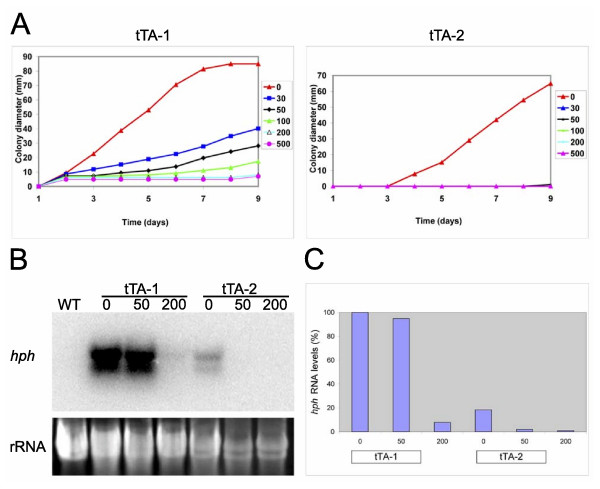
Effects of doxycycline on the hygromycin sensitivity of two A. fumigatus strains that express tTA (p444) in conjunction with the tetO7-hph reporter gene (p482). (A): Ten thousand conidia from the tTA-1 or tTA-2 transformants were spotted onto the center of a plate containing 1 mg/ml hygromycin and the indicated concentrations of doxycycline (μg/ml) and colony diameter was measured with time. (B): Doxycycline regulation of hph RNA levels in the tTA-1 and tTA-2 strains by Northern blot analysis. Total RNA isolated from overnight cultures grown in the presence of 0–200 μg/ml doxycycline was fractionated by agarose gel electrophoresis, transferred to nylon membranes, and probed with a 32P-labeled hph probe. (C): Hybridization intensity in each lane of the Northern blot in (B) was normalized to levels of the SYBR-green II-stained rRNA by phosphorimager analysis and is shown as a percentage of the levels seen in the tTA-1 transformant in the absence of doxycycline.